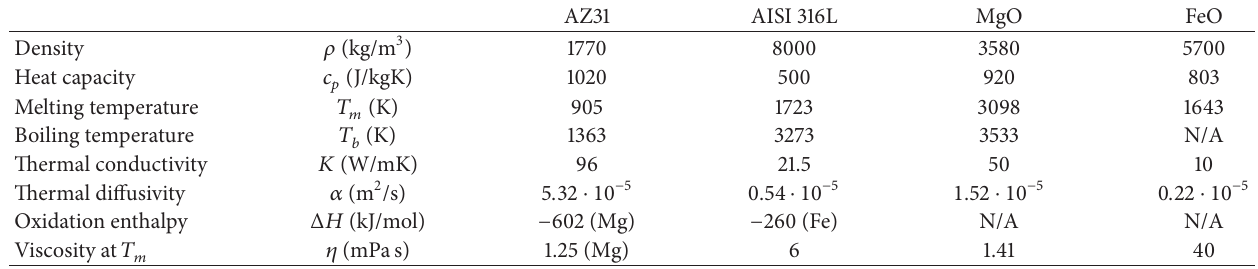
Table 3: Physical properties of the biodegradable stent material AZ31, the traditional stent material AISI 316L, and the oxides of their main alloying components, MgO and FeO [27–30].